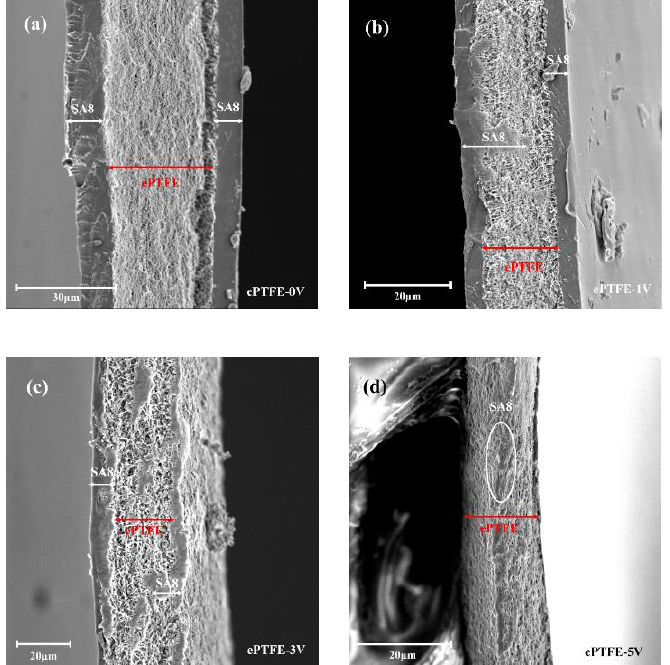
Figure 4. Cross-sections of ePTFE membranes under SEM: ( a ) ePTFE-0 V at 1:2800 scale; ( b ) ePTFE-1 V at 1:3600 scale; ( c ) ePTFE-3 V at 1:4400 scale; ( d ) ePTFE-5 V at 1:4100